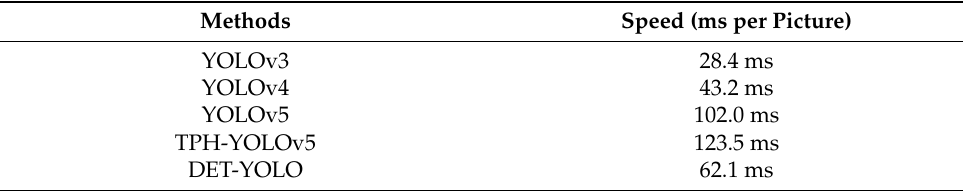
Table 7. A comparison of the inference times for various methods on DOTA datasets.